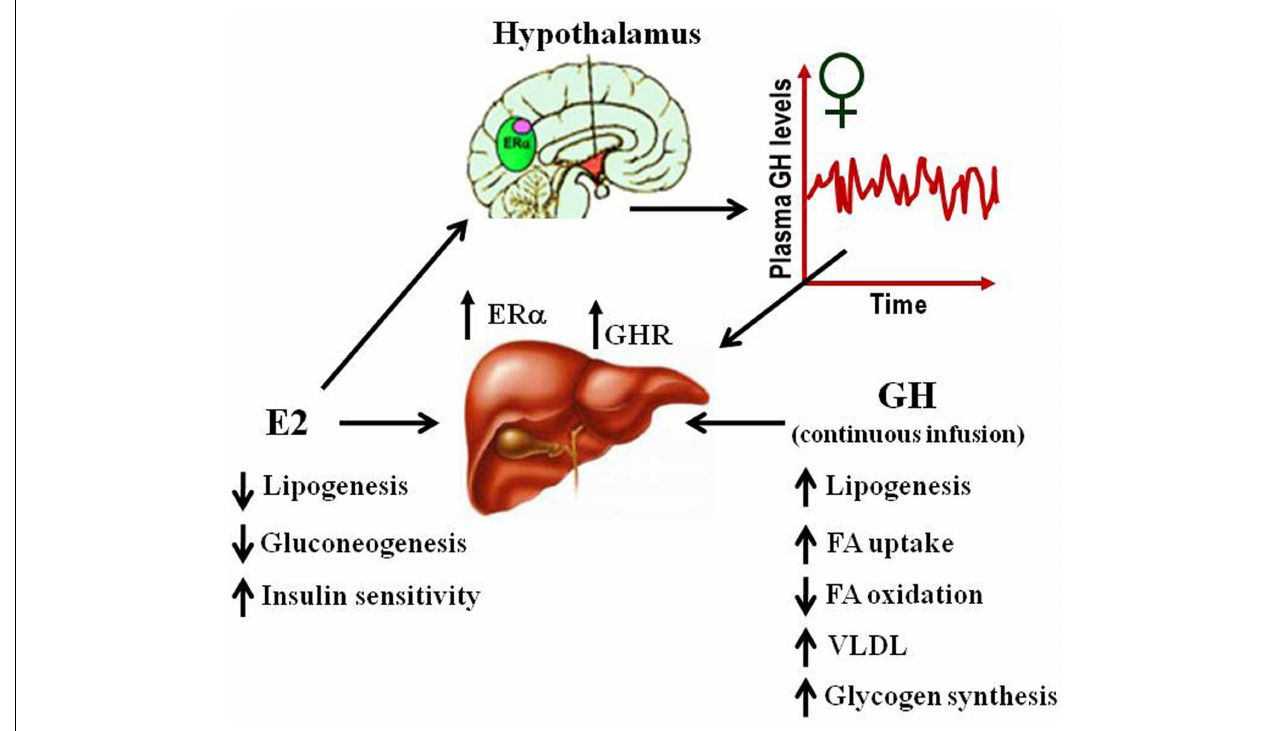
FIGURE 4 | Physiological effects of E2 and GH on lipid and glucose metabolism in liver